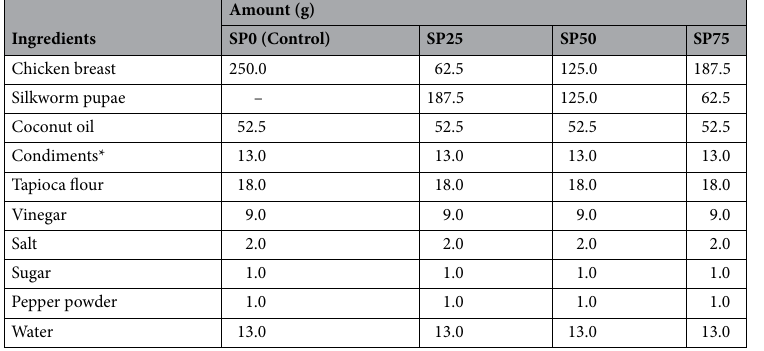
Table 1. Ingredients were used to prepare silkworm pupae-fortified chicken bread spread. Source: Modified from Arya et al. 10 . *Onion:ginger:garlic (3:2:1). SP0 (Control): Chicken bread spread without silkworm pupae fortification. SP25, SP50, and SP75: Silkworm pupae-fortified chicken bread spread with the replacement of chicken meat at 25, 50, and 75%,